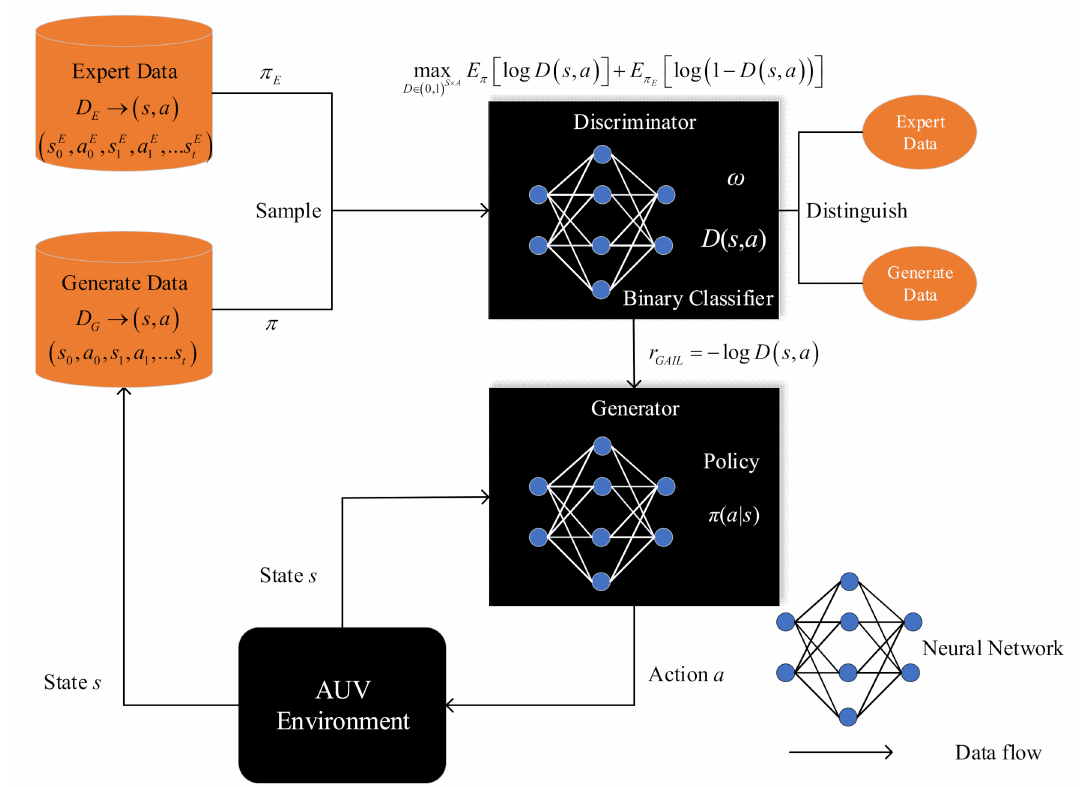
Figure 5. Neural network structure of the GAIL